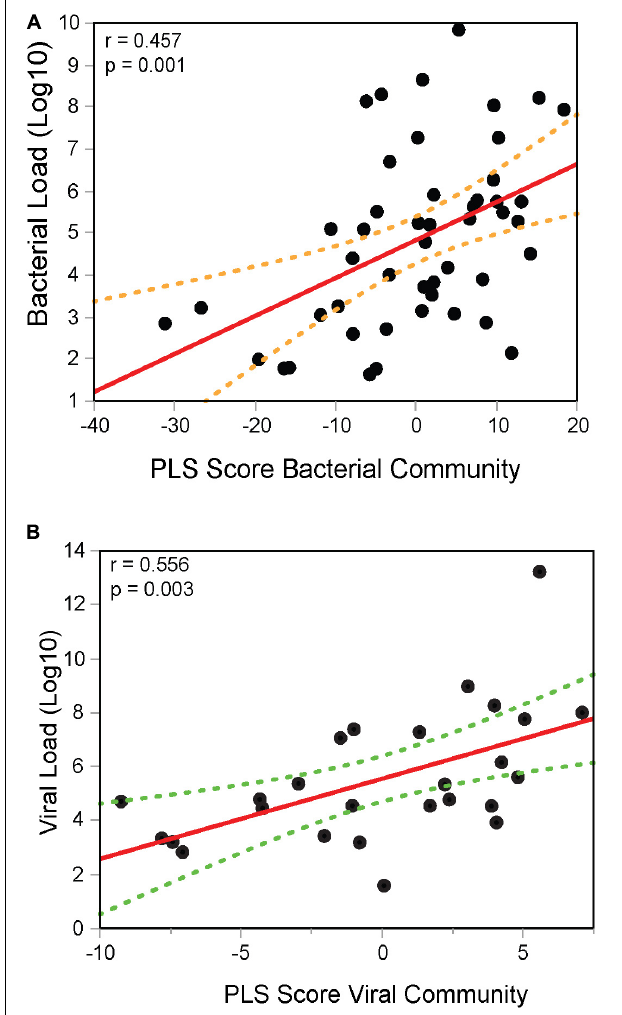
FIGURE 4 | Integrative analysis of gene expression module and microbial load in children with ARI. Bacterial (A) or viral (B) loads were correlated with partial least square (PLS) scores obtained for the modular communities of